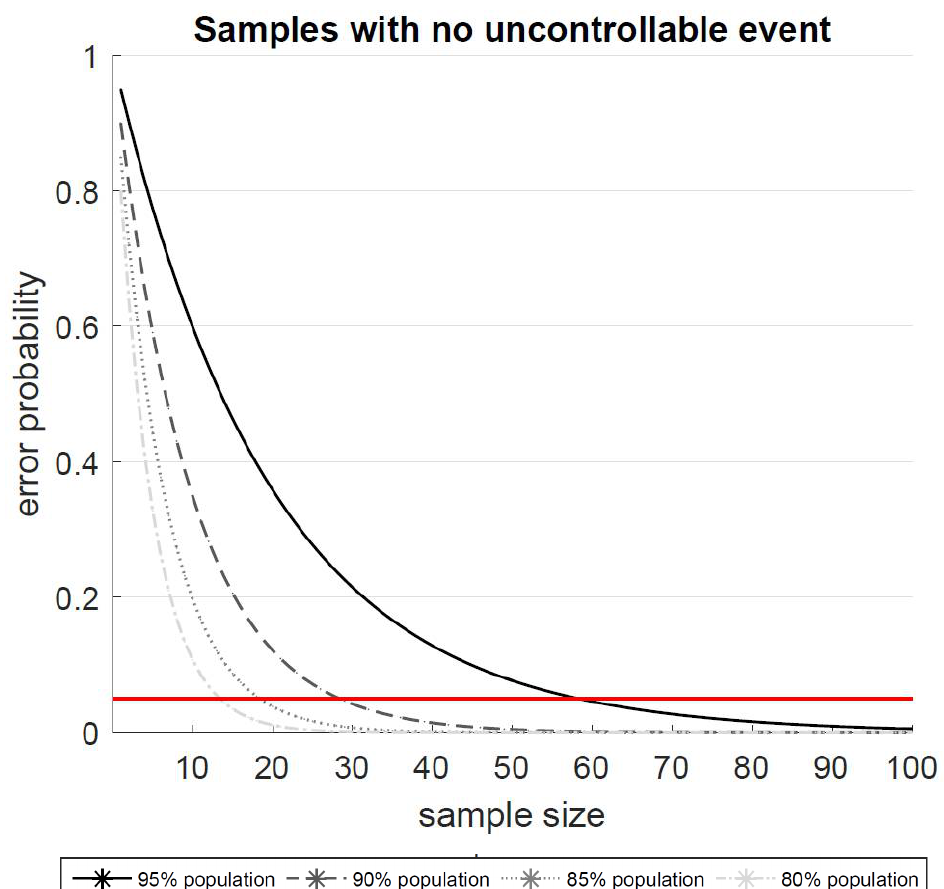
Figure 1 . Error probabilities for the four populations (80, 85, 90, and 95%) by sample sizes with no uncontrollable events.